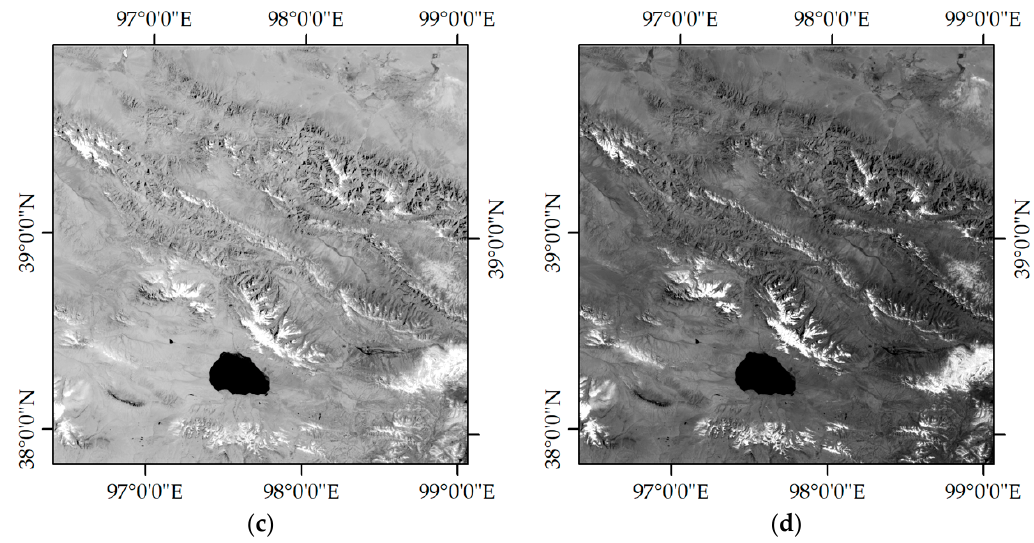
Figure 13. The NDSI r and RSI images calculated with the GF-4 PMS images: ( a ) NDSI r of test site No. 1; ( b ) RSI of test site No. 1; ( c ) NDSI r of test site No. 2; ( d ) RSI of test site No. 2. The four subfigures have the same north arrow and scale, which are marked in the upper left corner of the figure.